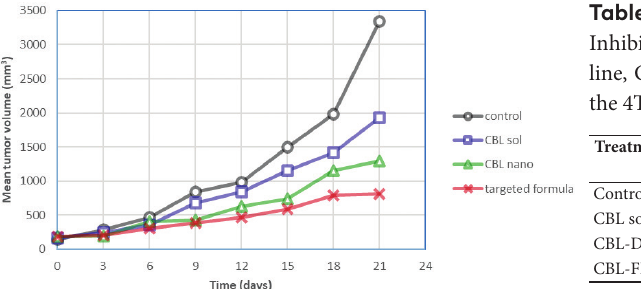
Figure 2 . Changes in the tumor volume as a function of time in 4T1 cell line mice model after the tail vein administration of nor- mal saline (control), CBL solution, non-targeted formulation, and targeted formulation, CBL dose adjusted to be 10mg/kg/week.